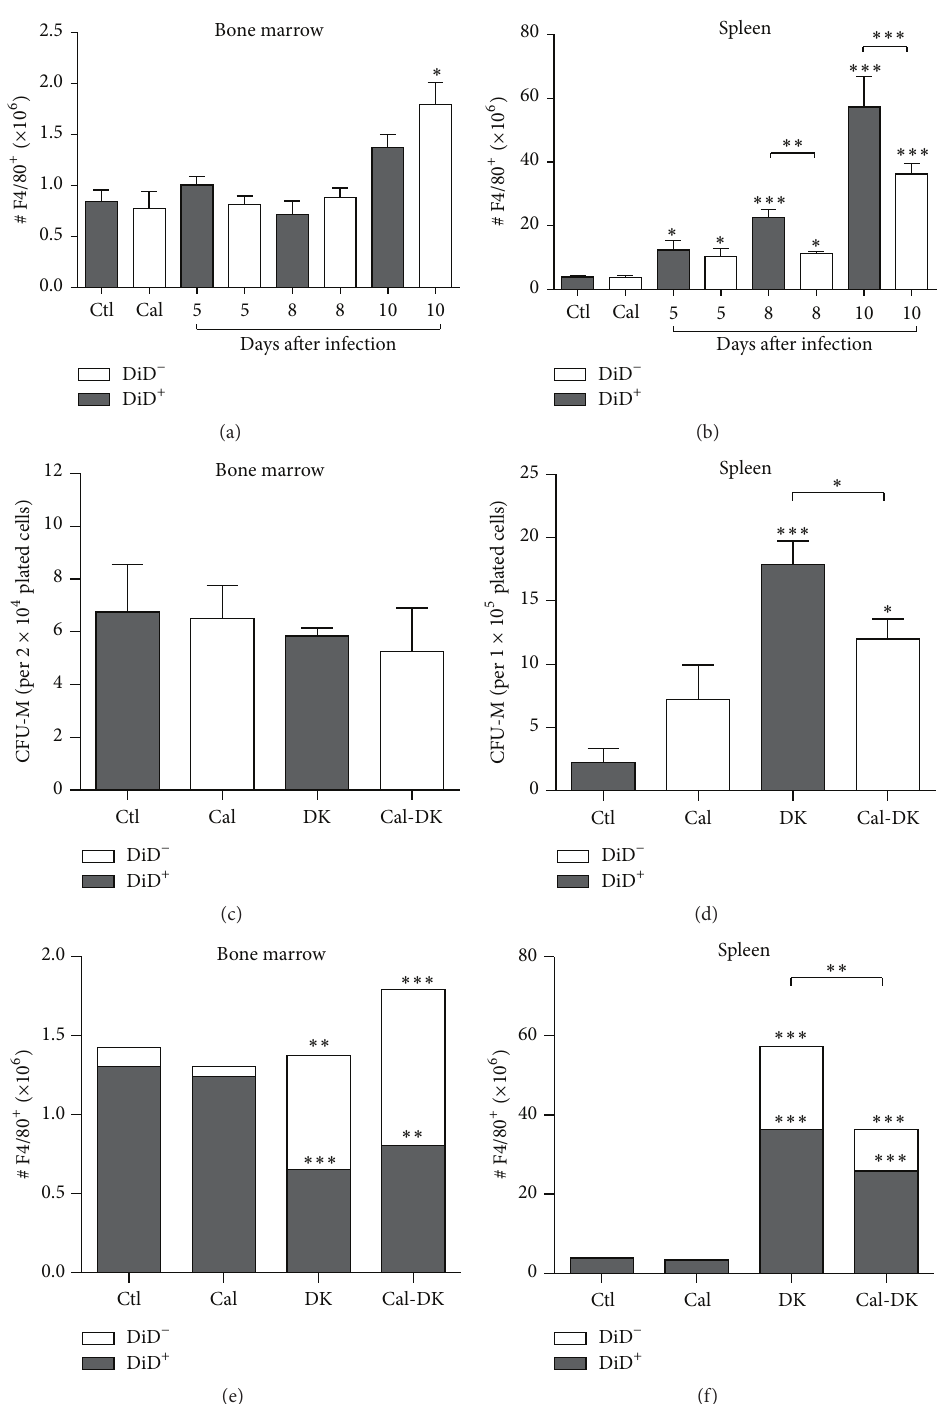
Figure 5: Modulation of macrophages population by calcitonin during Plasmodium infection. Before experimentation, mice were injected intravenously with DiD-liposomes for staining of phagocytic cells. Mice were treated with calcitonin (white bars; Cal) or with PBS (grey bars; Ctl) during 5 consecutive days and were infected with P. c. adami DK parasites (10 5 pRBCs) on the 3rd day of treatment. Data from uninfected controls (Ctl, Cal 𝑛 = 3 ) is included for comparison. Mice were sacrificed at 5 ( 𝑛 = 8 ), 8 ( 𝑛 = 8 –12), and 10 ( 𝑛 = 3 -4) days after infection and macrophages (F4/80 + cells) were assessed by cytofluorometry in bone marrow (a) and spleen (b). At 8 days after infection, the numbers of Colony Forming Unit-Macrophage (CFU-M) were determined in 12-day bone marrow (c) and spleen (d) cultures using MethoCult 03434 media. At 10 days after infection, the numbers of DiD + and DiD − negative macrophages (F4/80 + cells) were evaluated by cytofluorometry in bone marrow (e) and spleen (f). Data are mean ± SEM from 3 independent experiments (with a total of 19–24 mice per infected group); valuesarecomparedtorespectiveuninfectedcontrolmiceandbetweenthetwoinfectedmicegroupsusingaone-wayANOVAtest. ∗ 𝑃 < 0.05 ; ∗∗ 𝑃 < 0.01 ; ∗∗∗ 𝑃 < 0.001